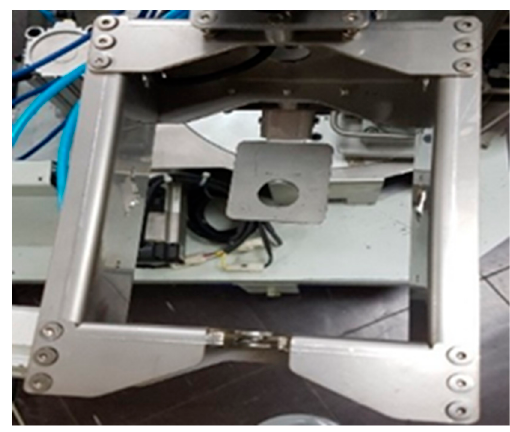
Figure 4. End-effector. Figure 4. End-e ff ector.